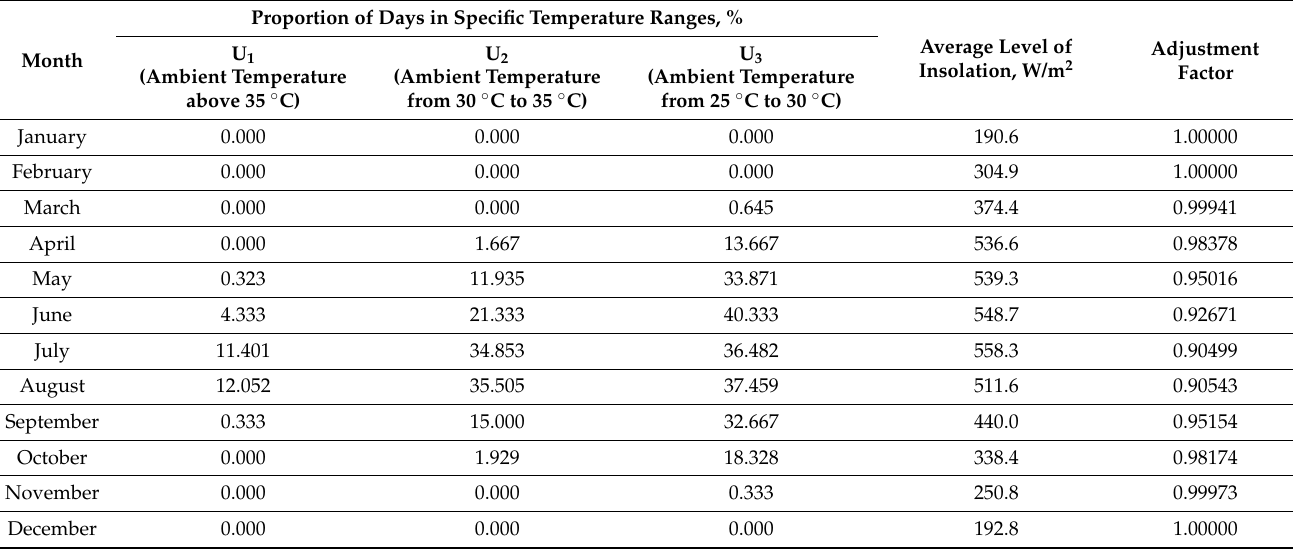
Table 3. Adjustment factor for the effect of temperature in each month with P max =